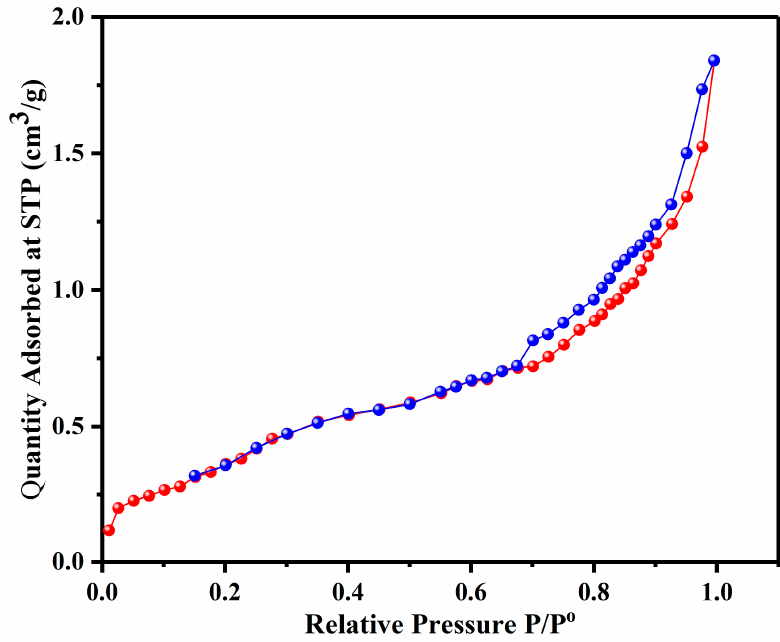
Figure 4. Pore size distribution of treated CH.